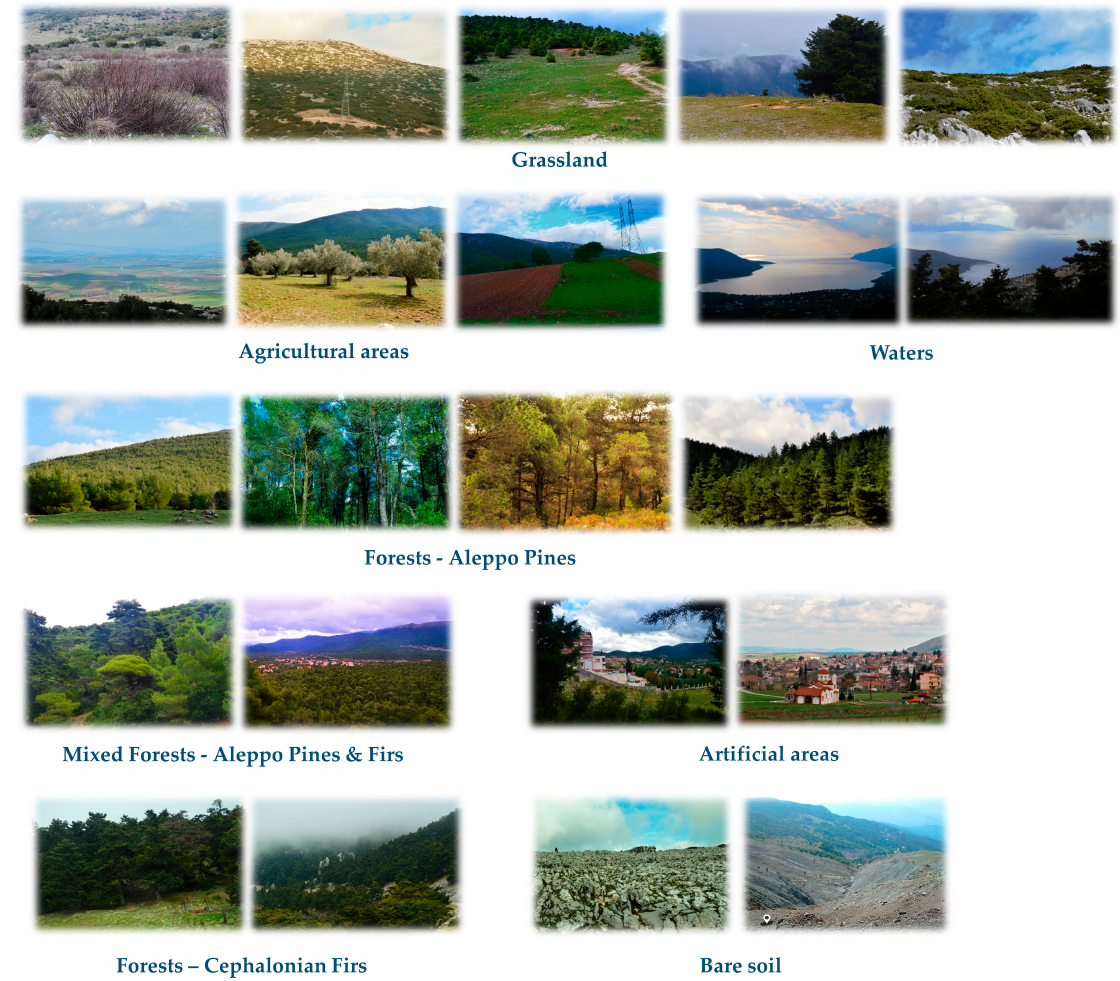
Figure 3. A selected list of the selected points for classification and validation reasons.